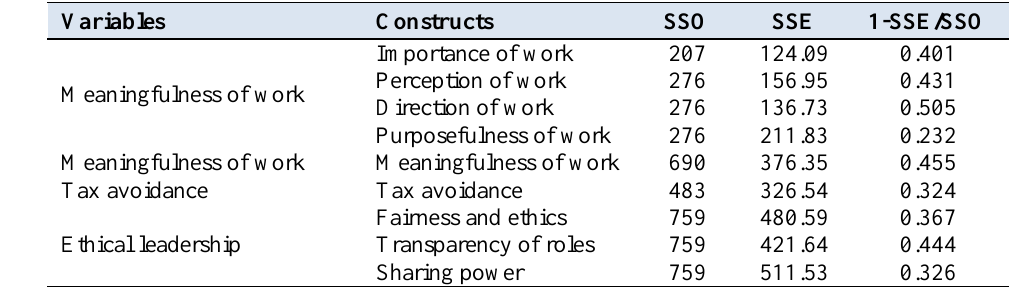
Table 6. Redundancy